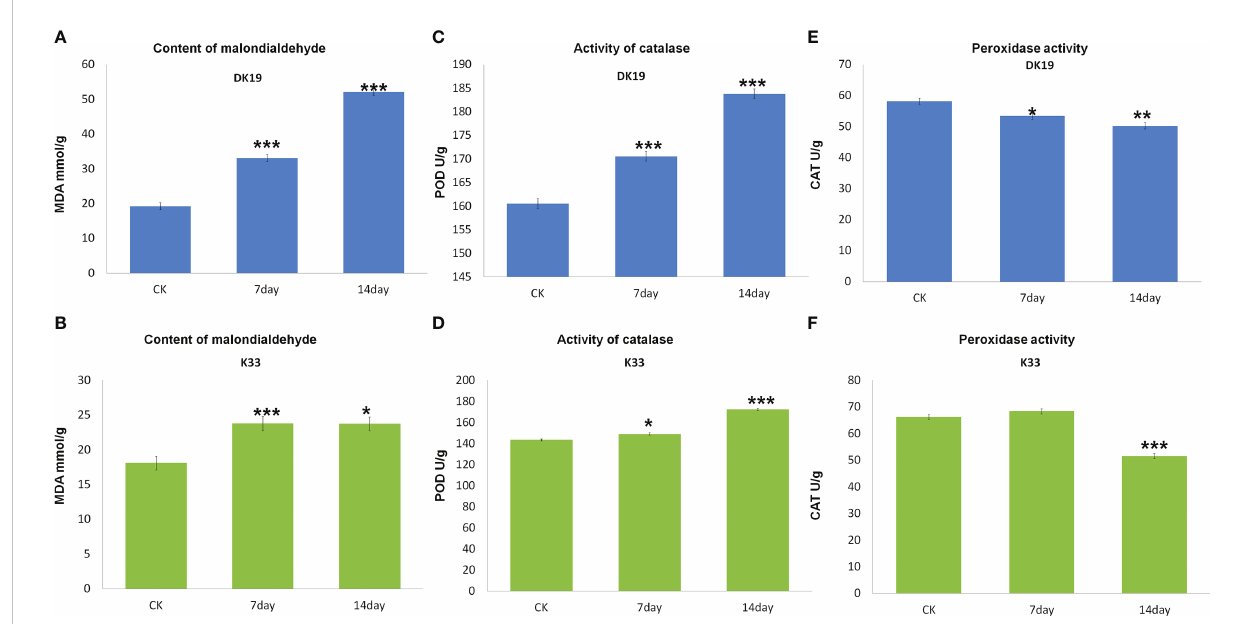
FIGURE 2 Difference of malondialdehyde content and antioxidant enzyme system between buckwheat DK19 and K33 under Cd stress. (A) Difference of MDA content in buckwheat leaves under Cd stress in DK19. (B) Difference of MDA content in buckwheat leaves under Cd stress in K33. (C) Difference of POD content in buckwheat leaves under Cd stress in DK19. (D) Difference of POD content in buckwheat leaves under Cd stress in K33. (E) Difference of CAT content in buckwheat leaves under Cd stress in DK19. (F) Difference of CAT content in buckwheat leaves under Cd stress in K33. * in green indicated that the difference of the same variety under different treatments is signi fi cant (P<0.05). * in black indicated signi fi cant difference (P<0.05) between different varieties under the same treatment. ** P ≤ 0.01, *** P ≤